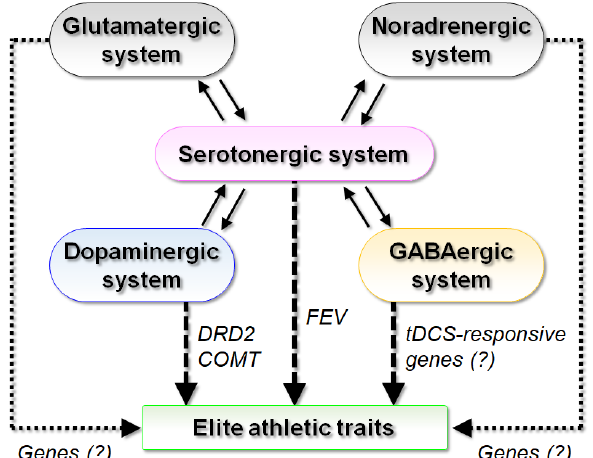
Figure 1. Potential implications of the CNS in a predisposition to elite athletic traits. The serotonergic system functionally interacts with multiple neurotransmitter systems, including the dopaminergic, GABAergic, glutamatergic, and noradrenergic systems. Genes related to these pathways (i.e., FEV in serotonergic system, DRD2 and COMT in dopaminergic system, and potentially tDCS-responsive genes in GABAergic system) have potential roles in a predisposition to elite athletic status. Hence, further studies are warranted to identify genes associated with the glutamatergic and noradrenergic systems. COMT , catechol-O-methyltransferase; DRD2 , dopamine D2 receptor; FEV , fifth Ewing variant; GABA, γ-aminobutyric acid; tDCS, transcranial direct current stimulation.